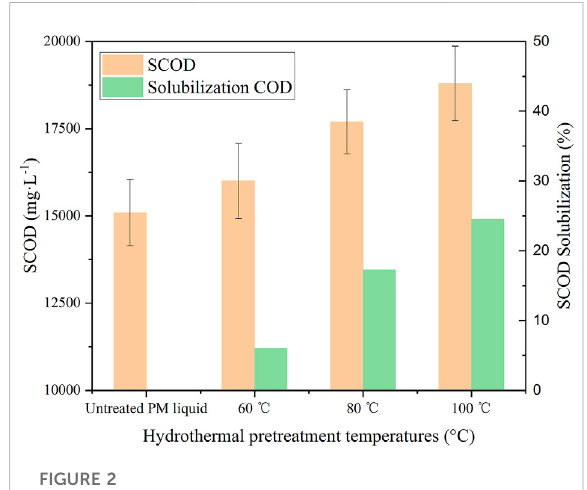
FIGURE 2 Enhancement of SCOD and COD solubilization by